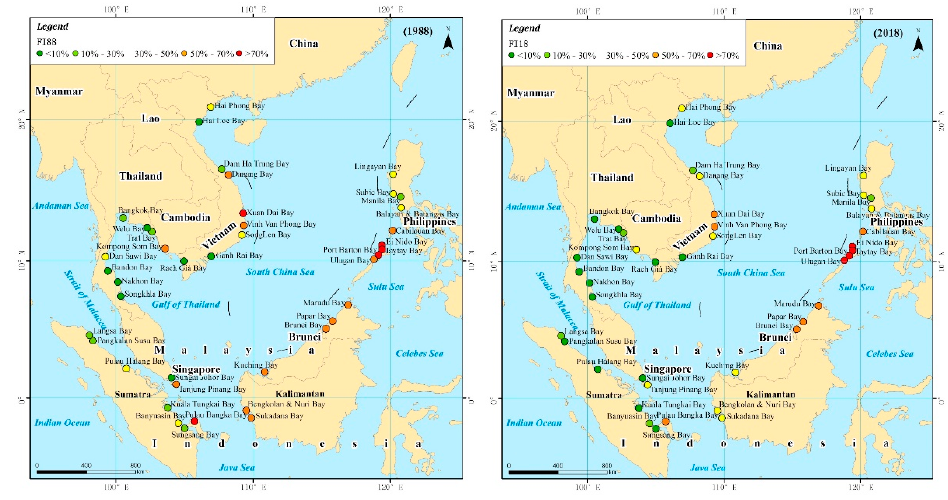
Figure 9. FI of the bays in 1988 and 2018.